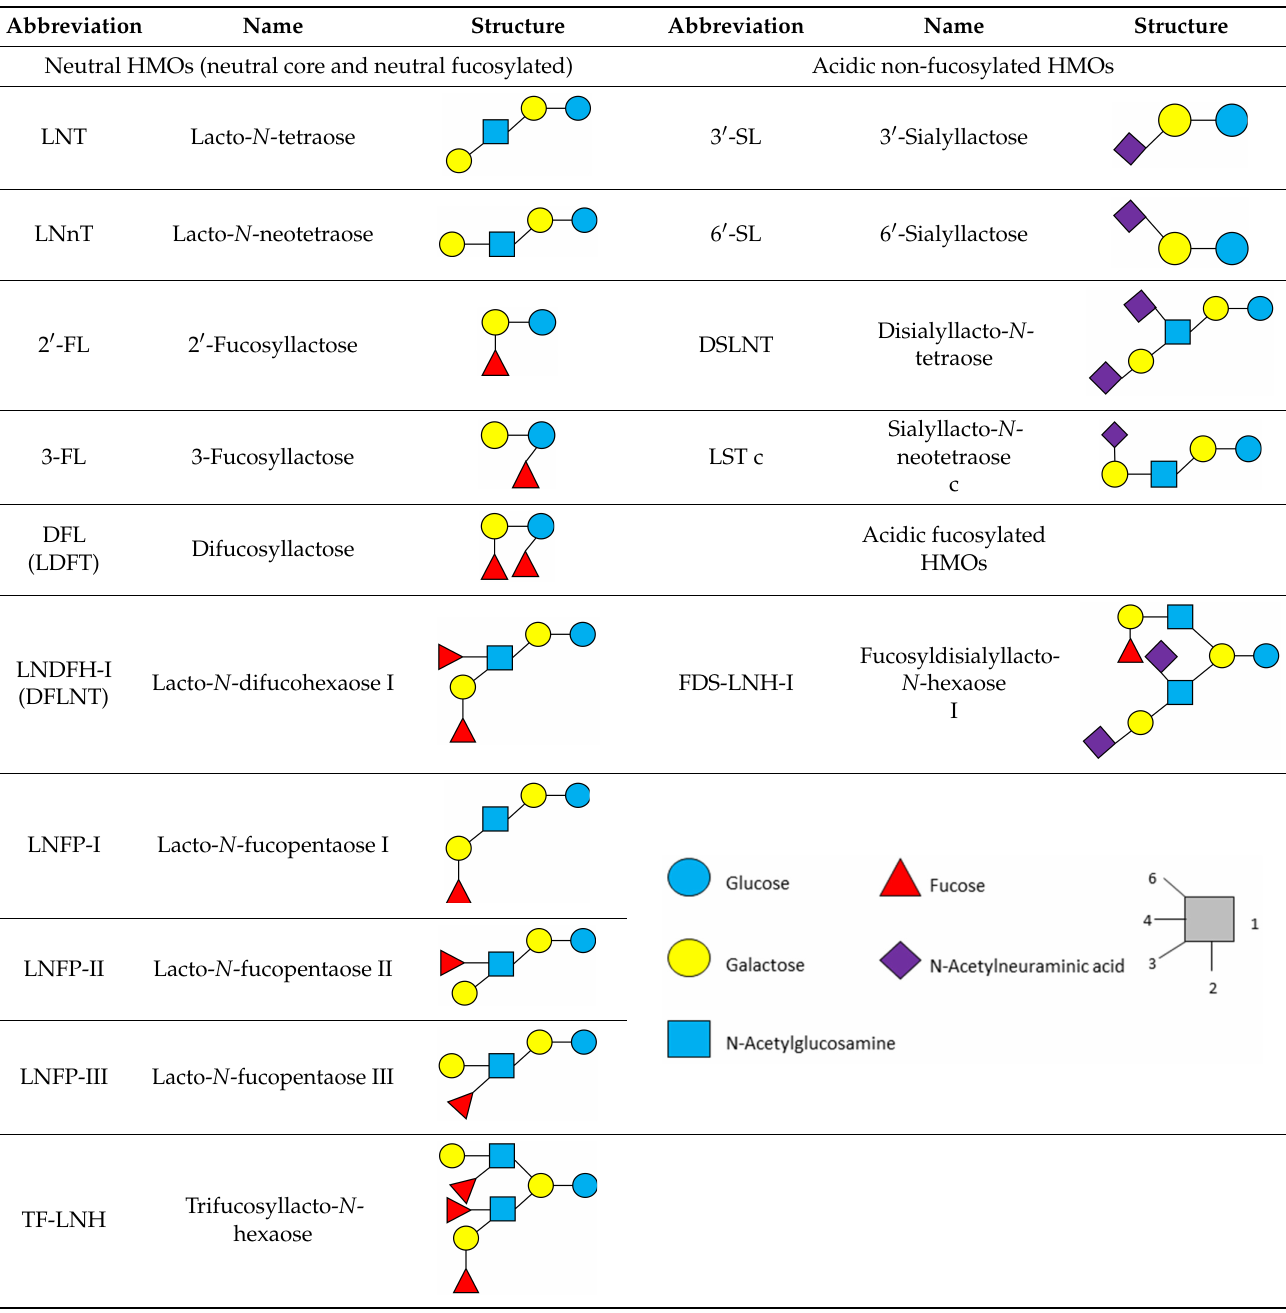
Table 1. Structures of the 15 most abundant HMOs in mature human milk reported in this